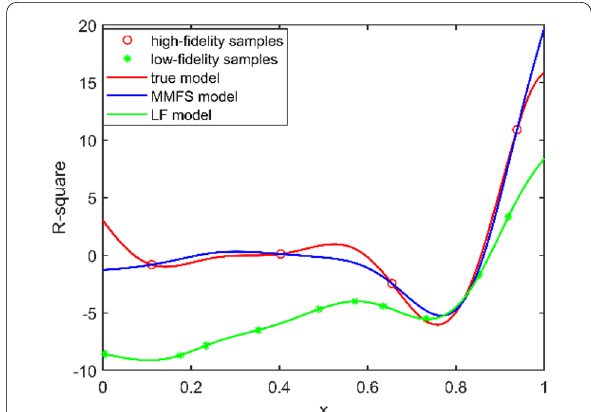
Figure 2 Distribution of sample points and surrogate models